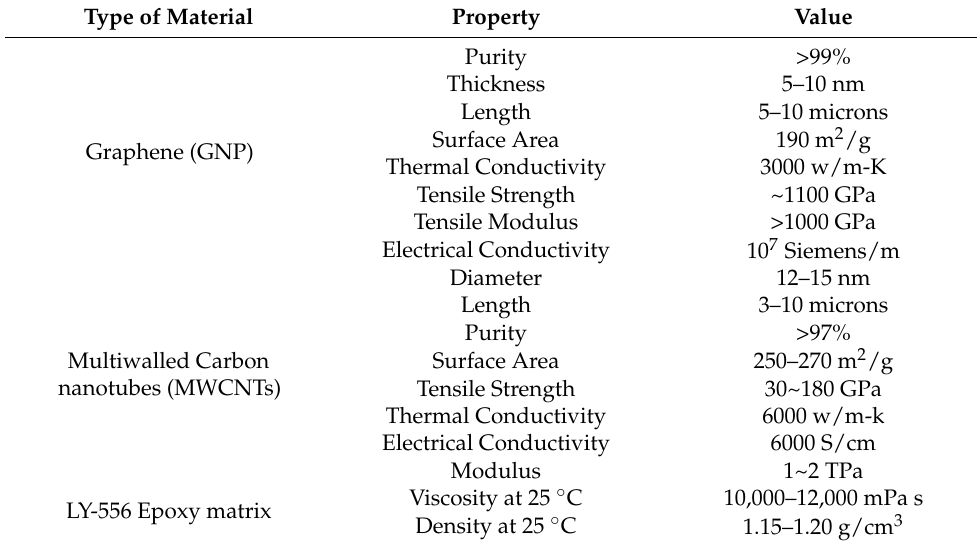
Table 2. Physical and mechanical properties of nanofillers and LY-556